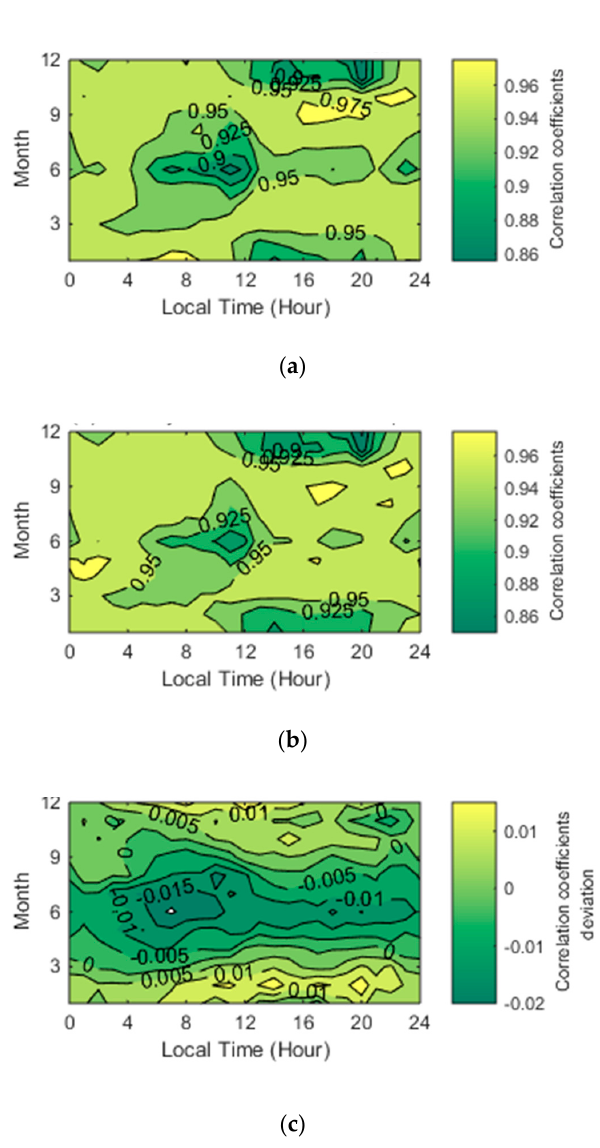
Figure 5. Correlation coe ffi cients between the monthly median values of critical frequency and the twelve-month running mean value of solar indices over Kokubunji, Japan. ( a ) The correlation coe ffi cients between monthly median f o F 2 and F 12 ; ( b ) the correlation coe ffi cients between monthly median f o F 2 and R 12 ; ( c ) the deviation of two type correlation coe ffi cients.